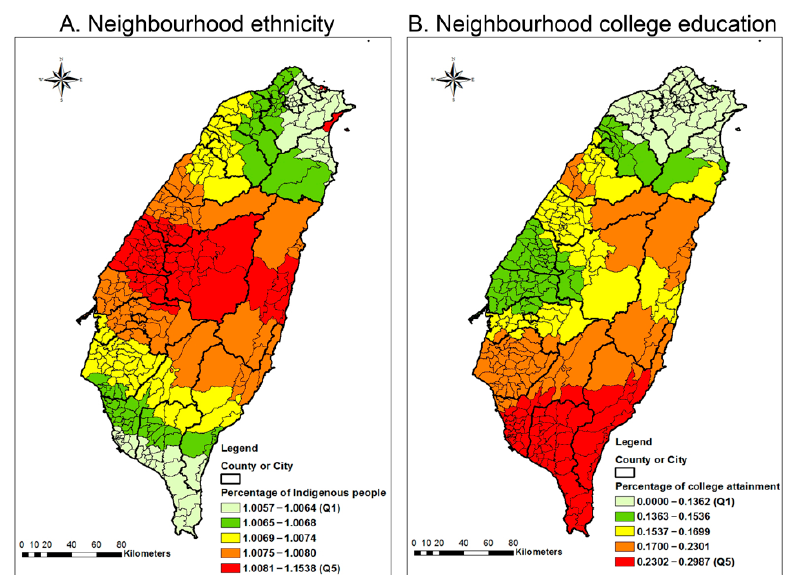
Figure 2. Maps of the GTWR effect sizes for the effect of neighbourhood factors on age-standardized premature mortality. The effect sizes were drawn from a GTWR model that regresses premature mortality on the percentage of Indigenous people, median household income, and percentage of people with a college education. The black line indicates the boundary of a county or city. The grey line indicates the boundary of a township/neighbourhood in a county or city.